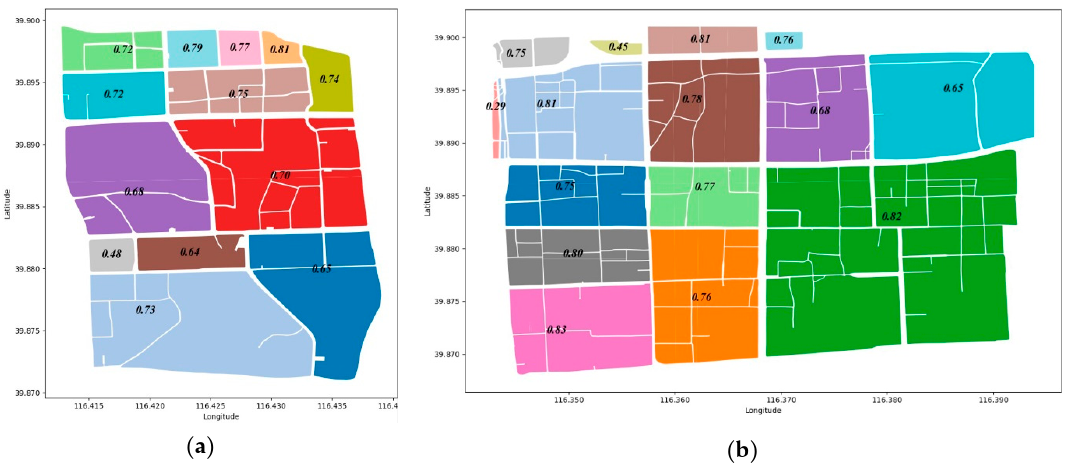
Figure 17. Illustration of grouping results based on UPG: ( a ) grouping result of Parcel 1 and ( b ) grouping result of Parcel 2 . Numbers within groups represent the MLU index. Table 5. Analysis of parcel grouping results based on infiltration behaviours (UPG).